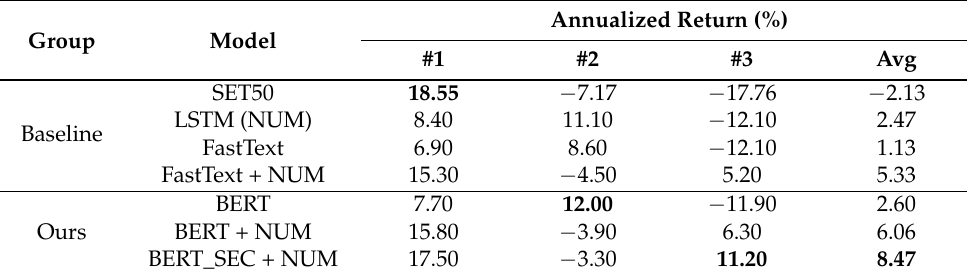
Table 10. Model comparison in terms of “Annualized Return” on testing data based on a 3 fold-cross validation (#1, #2, #3 refers to the result of each fold), and boldface is the